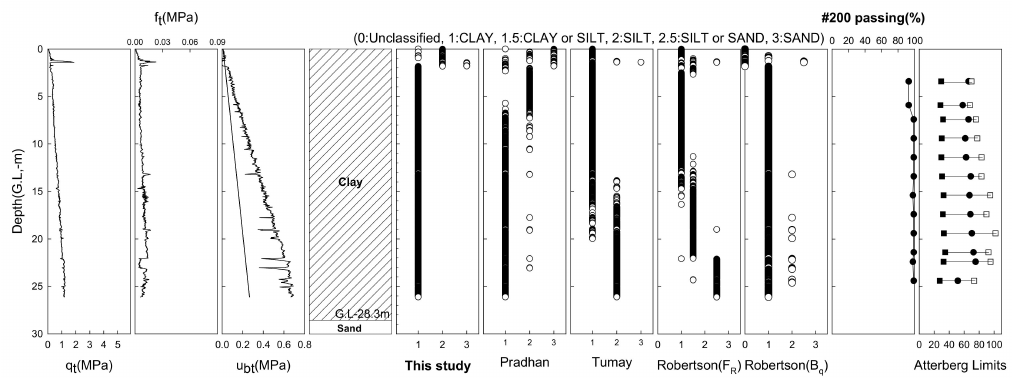
Figure 10. Verification results at Busan new port site-2.